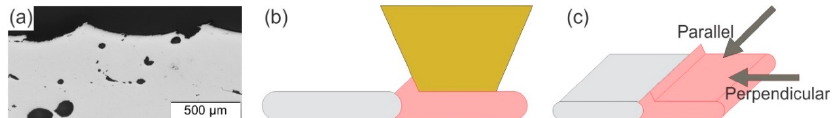
Figure 11. ( a ) Effect of excessive overextrusion on the top extruded layers; ( b ) schematics of the origin of the overextrusion defects by the extrusion of a new road of hot material (in red) over a previously deposited road of cold material (in gray); ( c ) schematics of the material deposition on top of a road with overextrusion if the roads of the new layer are parallel or perpendicular to it.